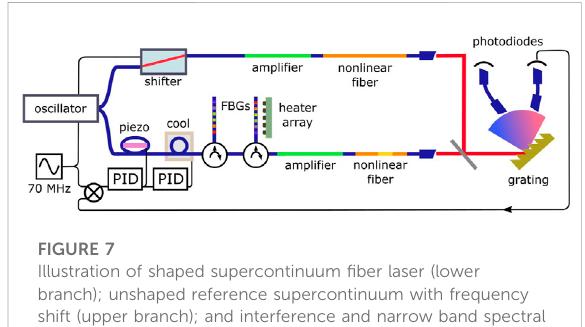
Illustration of shaped supercontinuum fi ber laser (lower branch); unshaped reference supercontinuum with frequency